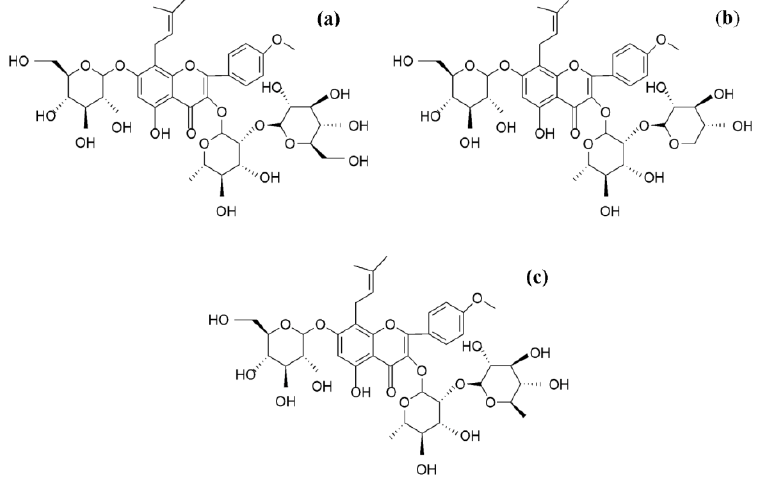
Figure 1. Chemical structures of ( a ) epimedin A; ( b ) epimedin B; and ( c ) epimedin